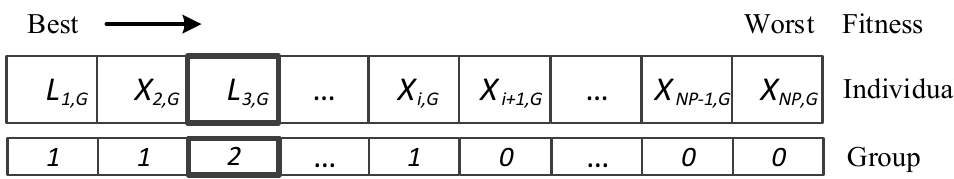
Figure 7. Generation of the first group members.